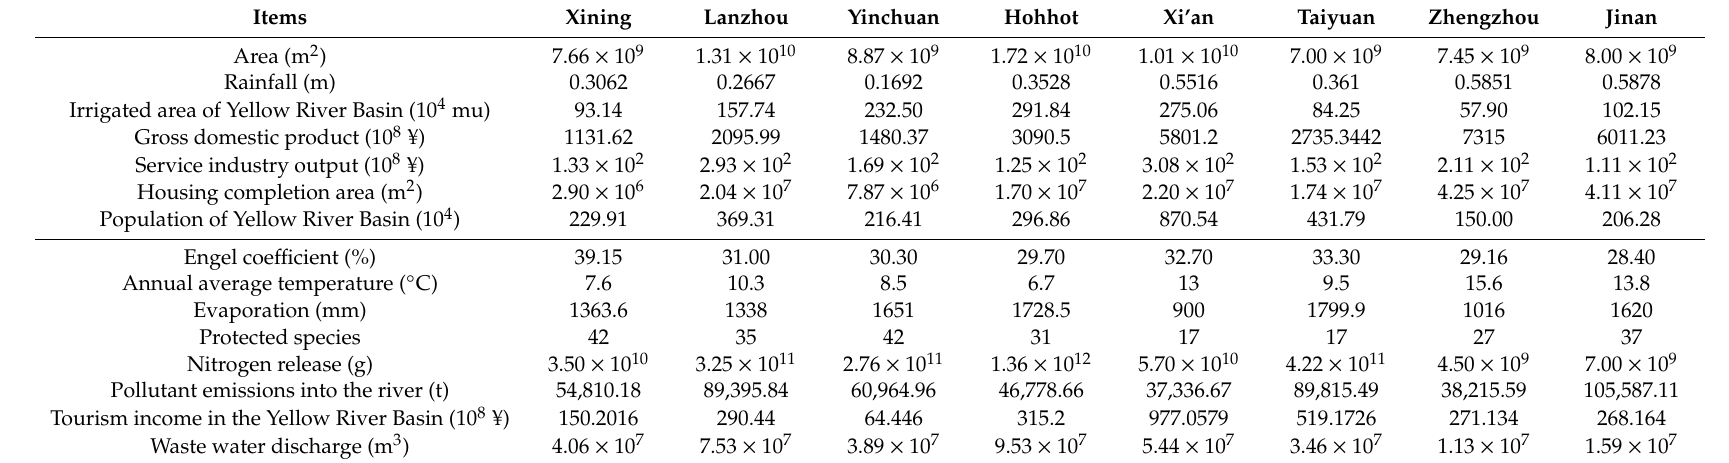
Table 2. Raw data of typical cities of the Yellow River Basin in